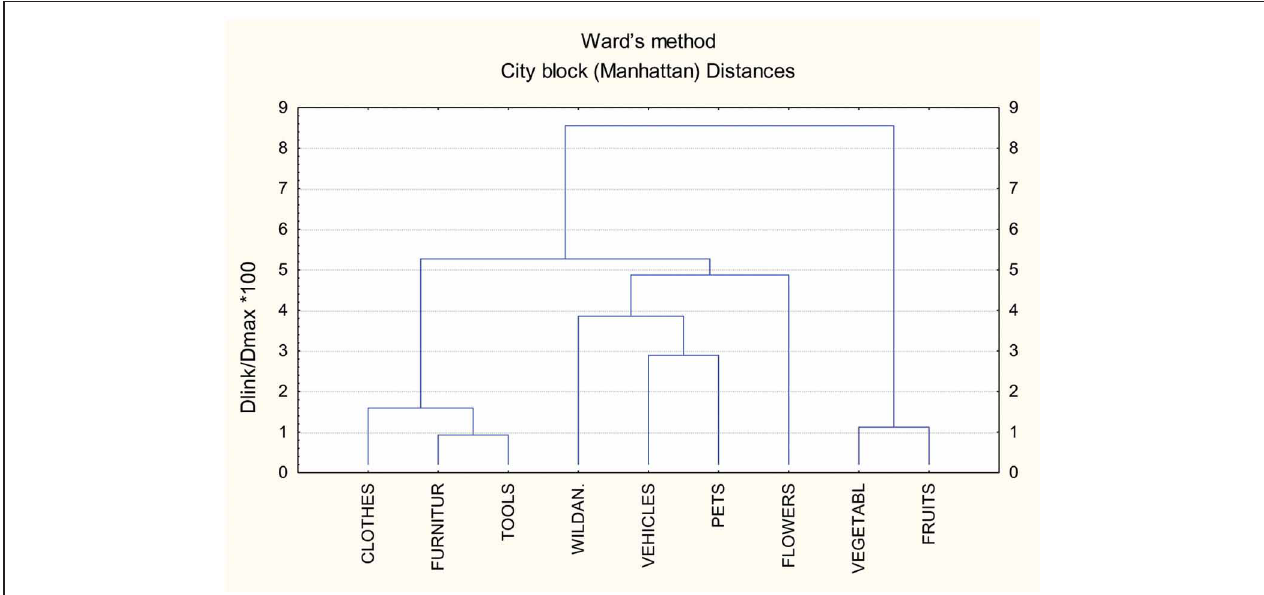
FIGURE 1 | Cluster analysis of the semantic categories grouped in terms of salience of the different sources of